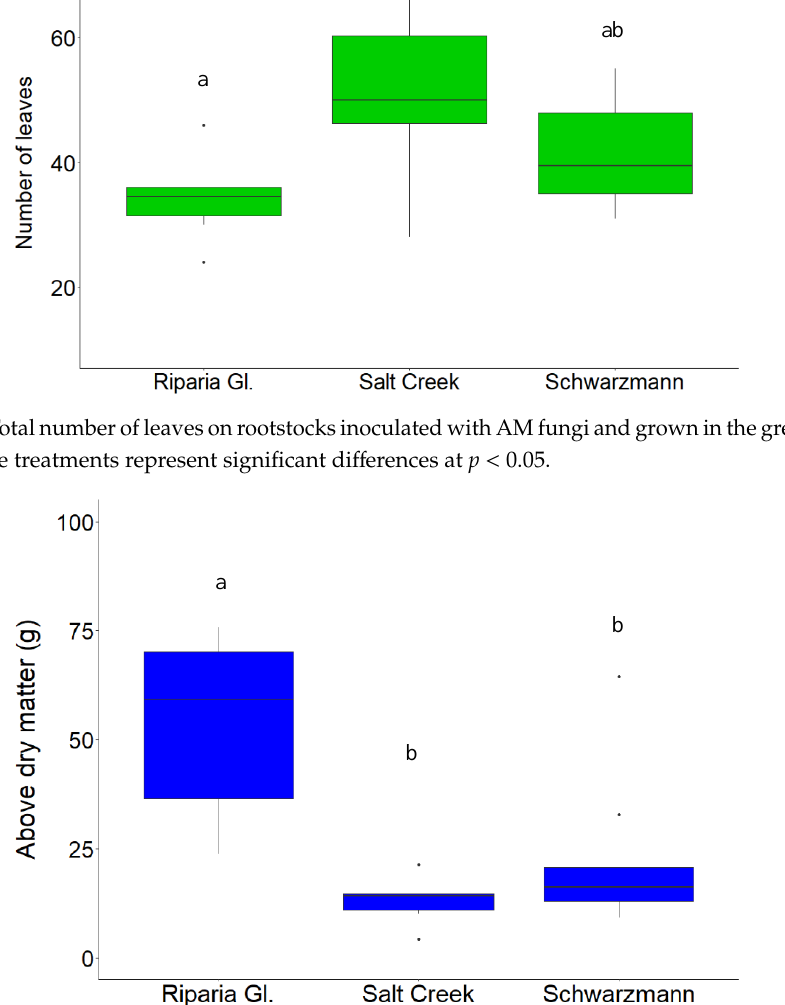
Figure A2. Shoot dry matter (g) in grapevine rootstocks inoculated with AM fungi at one year of field cultivation. Letters above treatments represent significant differences at p < 0.05.